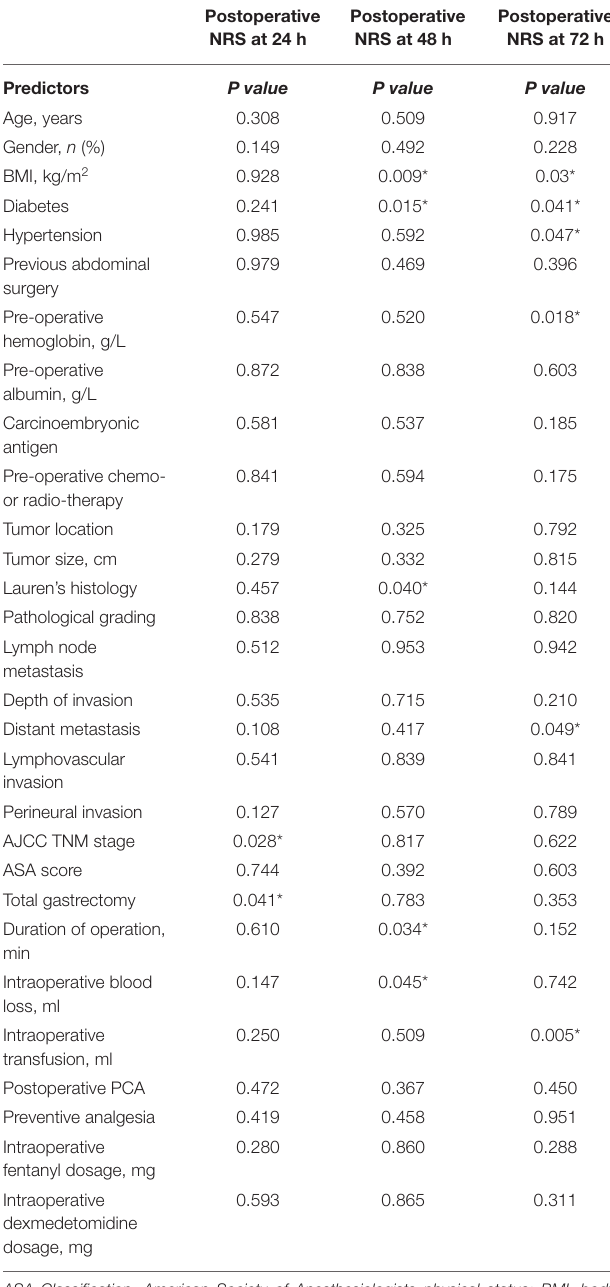
TABLE 2 | Univariate analysis of predictive factors for pain within 72h after OG. Postoperative NRS at 24